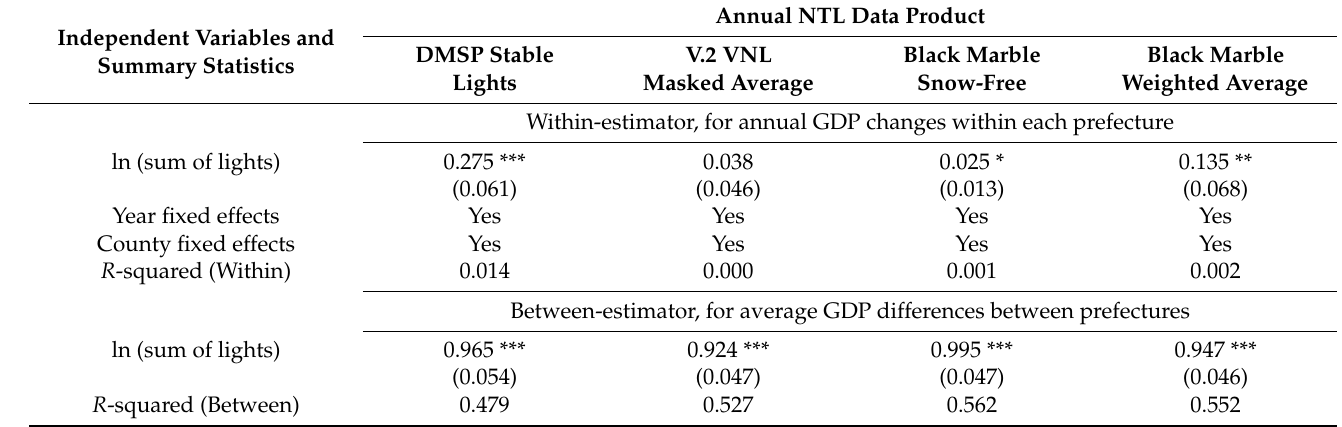
Table 4. Relationships between multi-source NTL and prefectural-level GDP: within and between- estimator’s